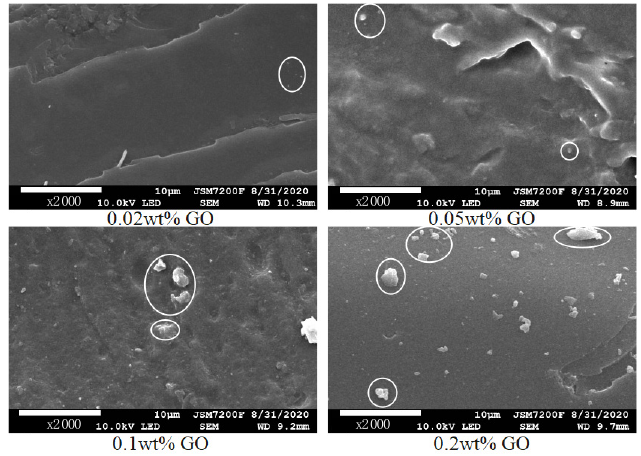
Figure 12. SEM images of epoxy resin–GO nanocomposites.